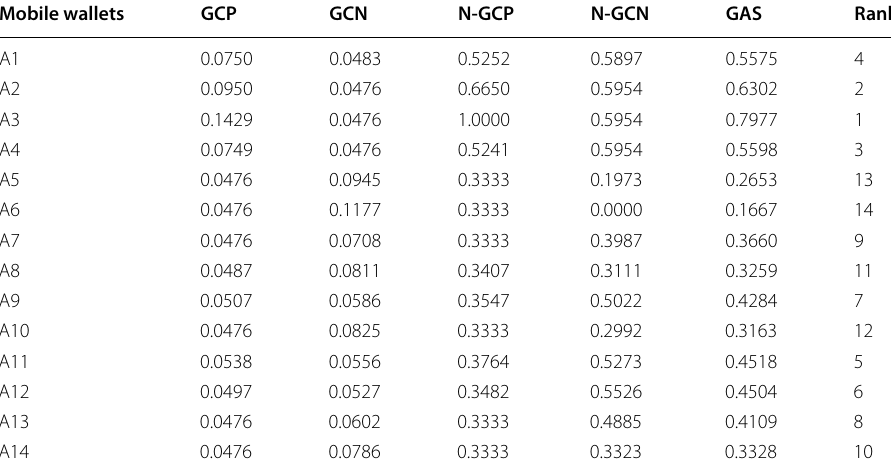
Table 12 Grey-correlation based ranking of wallets Mobile